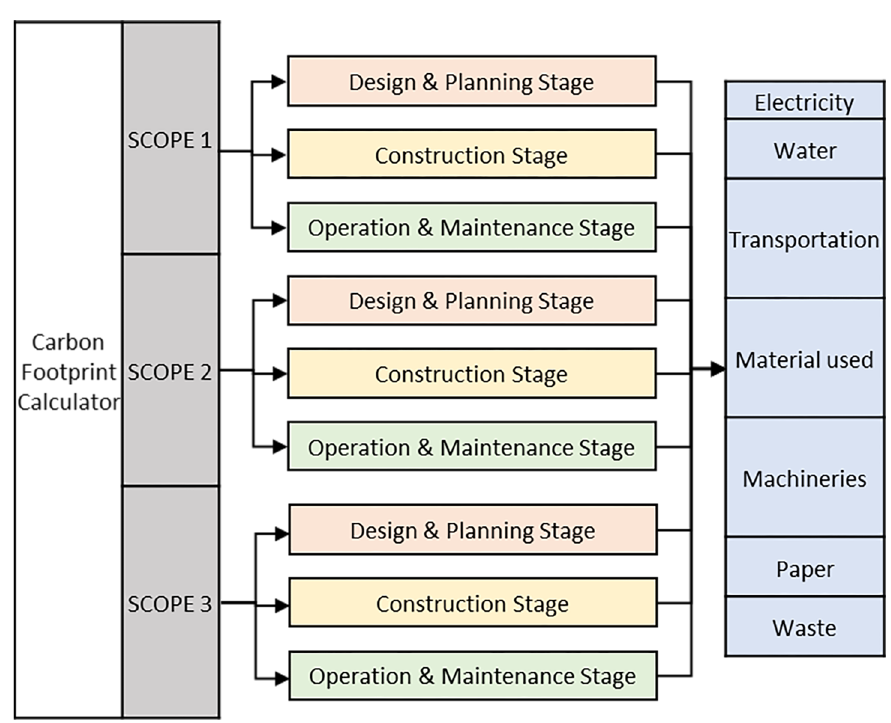
Figure 3. Data for integration from